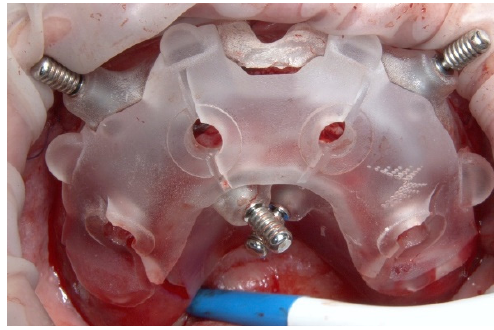
Figure 11. Base-portion plus implant-portion.